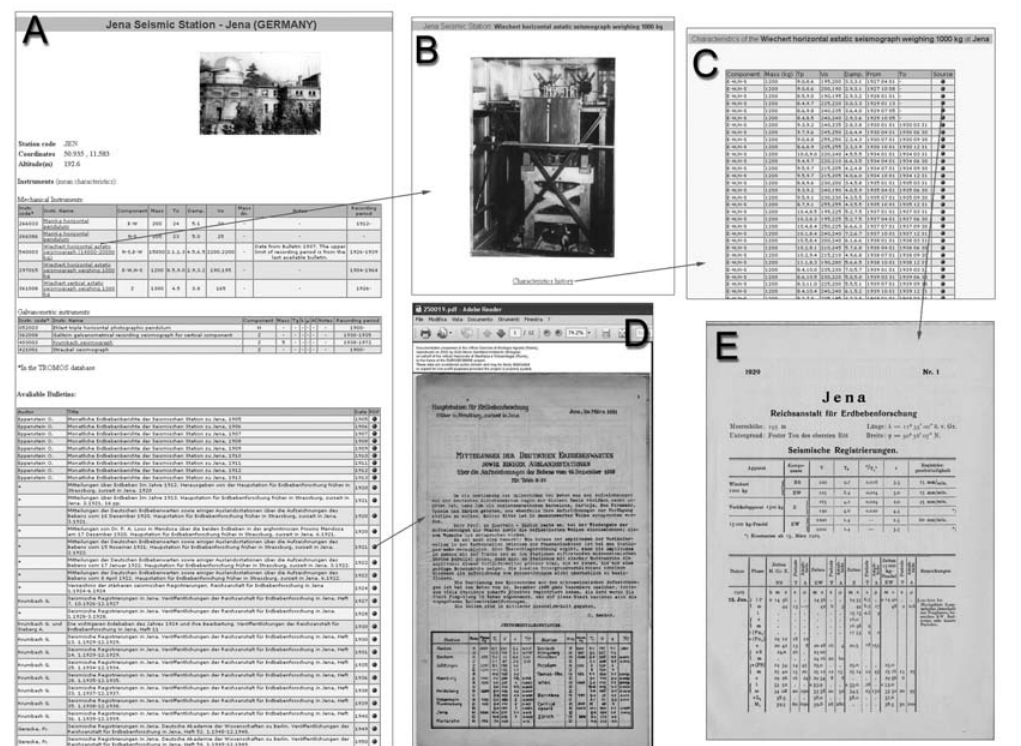
Fig. 15. Example of consultation through the ES website of the complementary documentation relating to the Jena observatory, collected and scanned within the scope of the TROMOS and EUROSEISMOS projects and stored in the TROMOS database. In the main page of the station (A) the following are indicated: name, location, province or region, nation, international code, geographical coordinates and quota. Also present, when available, are observatory photos. The tables relating to the instruments that have worked at the station follow, divided in- to mechanical and galvanometric. For each instrument the main average constants and the recording period are indicated; by clicking on the name a page opens with the image of the single instrument (B); through a link it is possible to access the page relating to the instruments’ seismic constant history (C); for each time-interval the constants refer to, there is a link that enables the viewing of the scan of the single page of the bulletin from which the information has been drawn (D). At the bottom, in the main page of the station (A) the available bulletins are listed in a table, with the indication of the author, the title and the year of the edition; through a link it is pos- sible to open the PDF of the integral raster reproduction of the